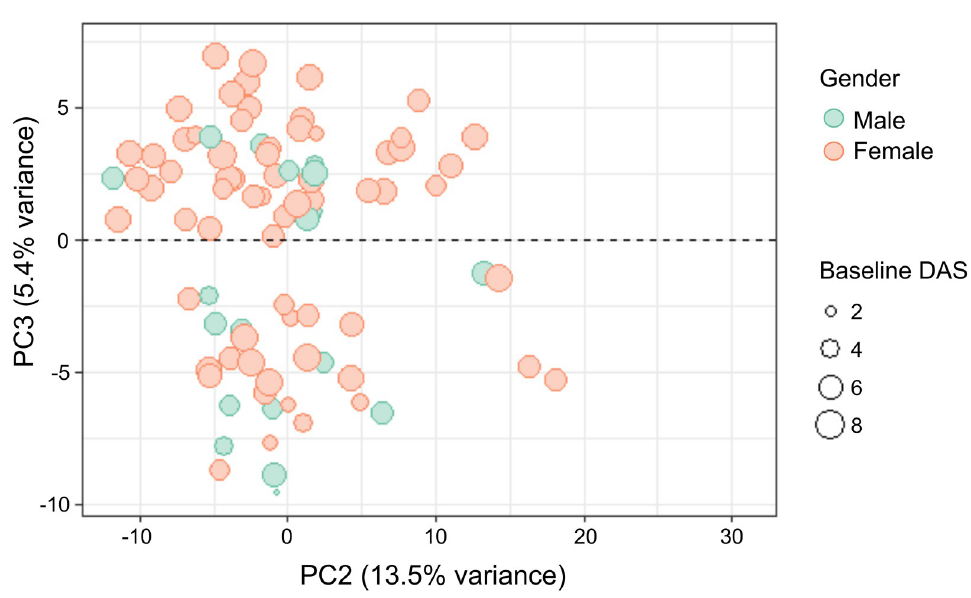
Fig 1. Principal component analysis (PCA) plot of rheumatoid arthritis patients (n = 89) using 352 plasma protein Normalised Protein Expression (NPX) values reveals two molecular sub-classes or endotypes with respect to positive and negative third principal component (PC3) values. Endotype 1 is with PC3 values > 0 and endotype 2 is with PC3 values < 0. Each data point represents a patient, where size of the dot is proportional to the disease activity score (DAS) of the patient at baseline.